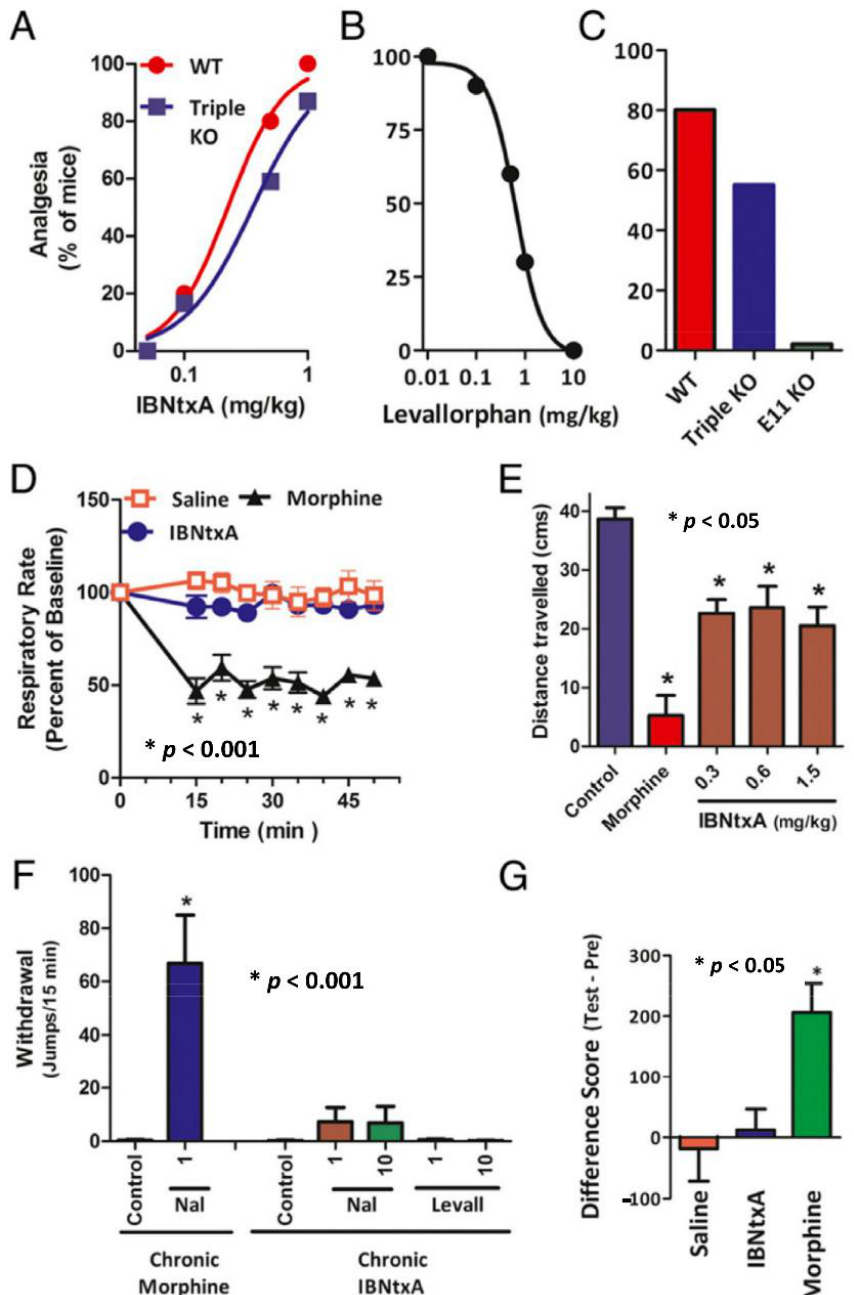
Figure 2. IBNtxA pharmacology (adapted from [101]). ( A ) IBNtxA analgesia. ED 50 values (and 95% confidence limits) obtained from dose–response curves were 0.22 mg/kg (0.13, 0.32) in WT mice and 0.39 mg/kg (0.15, 0.58) in triple-KO mice by using the radiant heat tail-flick assay. ( B ) Reversal of IBNtxA analgesia by levallorphan. IBNtxA (0.75 mg/kg, s.c.). ( C ) IBNtxA analgesia in KO mice (IBNtxA, 0.5 mg/kg, s.c.). ( D ) Respiratory rate. It was assessed in awake, freely moving CD1 mice that had been administered morphine (20 mg/kg, s.c.), IBNtxA (2.5 mg/kg, s.c.), or saline using the MouseOx pulse oximeter system (Starr Life Sciences). ( E ) Gastrointestinal transit. Morphine (5 mg/kg, s.c.). ( F ) Physical dependence. After being treated with morphine (10 mg/kg, s.c.) or IBNtxA (1 mg/kg, s.c.) for 10 days, mice were challenged with indicated naloxone. The number of jumps during 15 min was counted. ( G ) Conditioned place preference in a two-compartment apparatus with IBNtxA (1 mg/kg) or morphine (10 mg/kg).